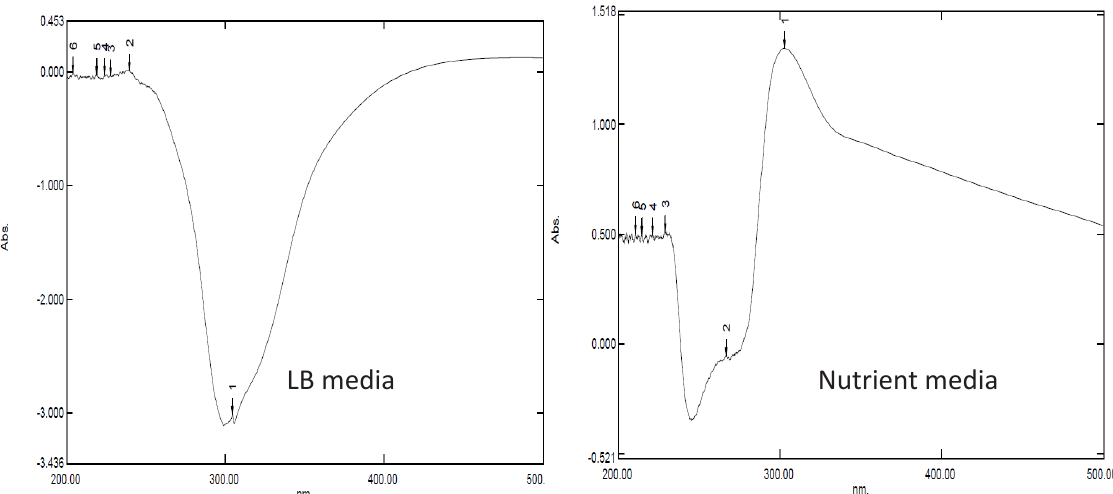
Fig. 3. UV-vis spectrum of silver nanoparticle produced by Escherichia coli in LB media and Nutrient media